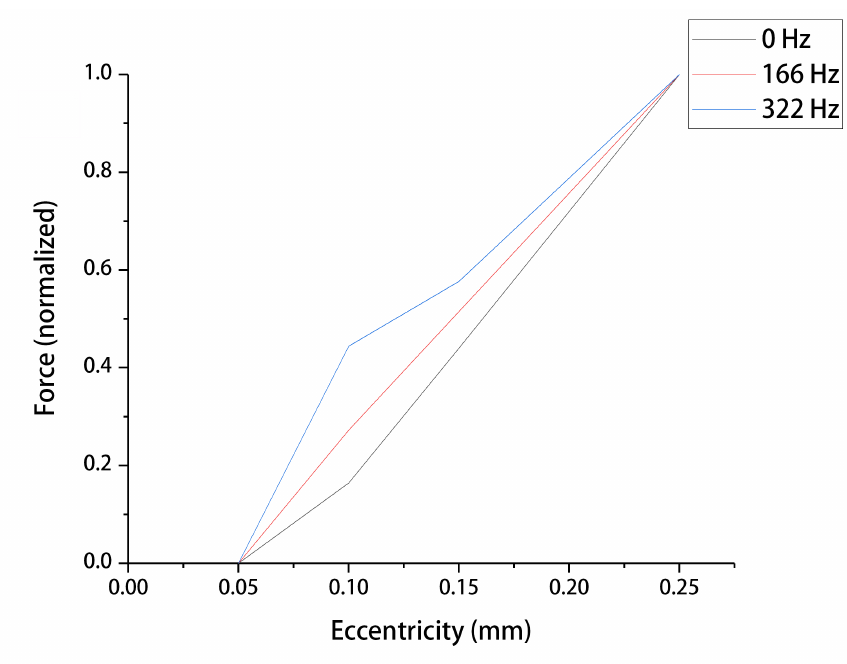
Figure 16. The relationship between the UMP and eccentricity.